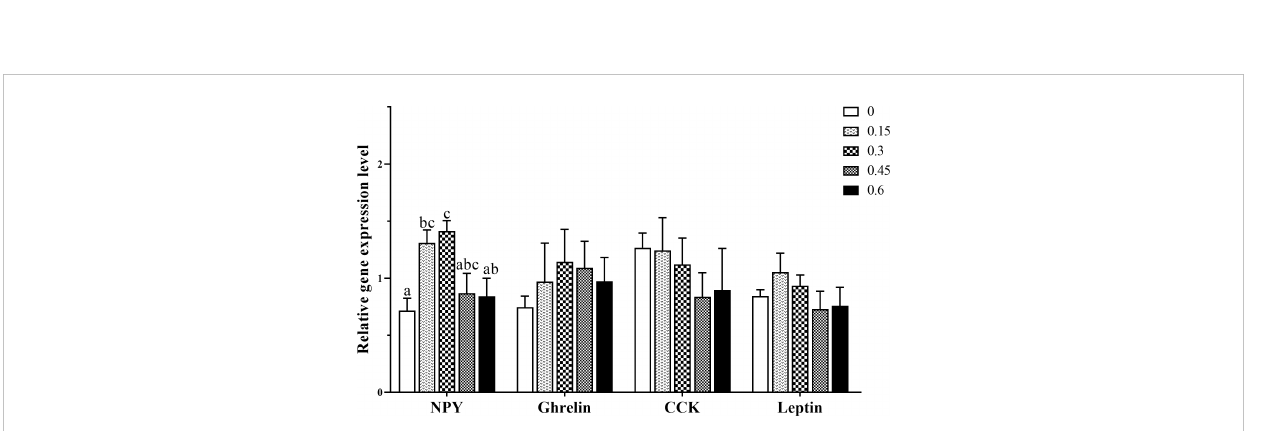
FIGURE 2 Effects of dietary bile acids levels on feeding regulation-related gene expression in the hypothalamus of coral trout. Values are expressed as mean ± S.E.M (n=6). Different letters indicate signi fi cant differences among groups ( P < 0.05). NPY, neuropeptide Y CCK,